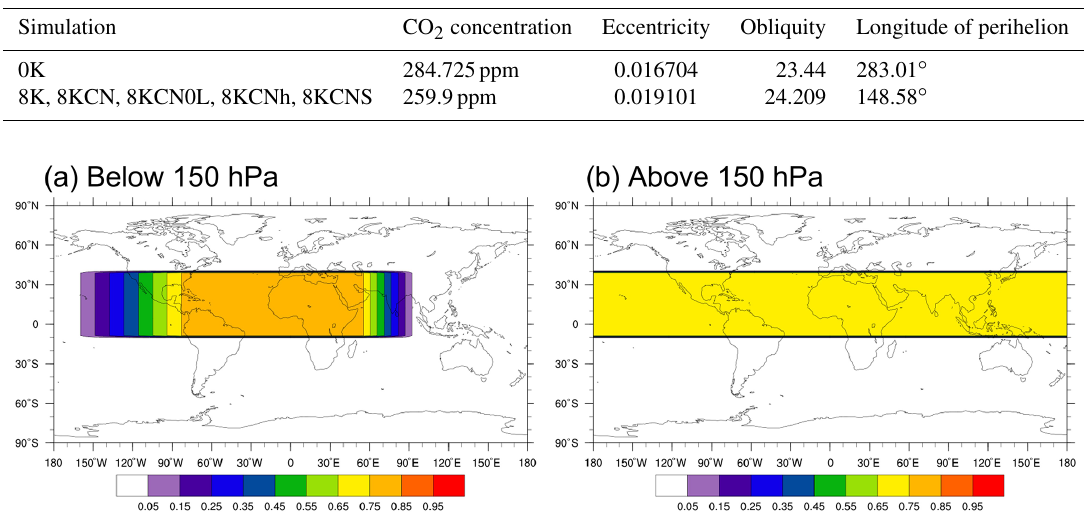
Table 2. Orbital parameters prescribed for the simulations.